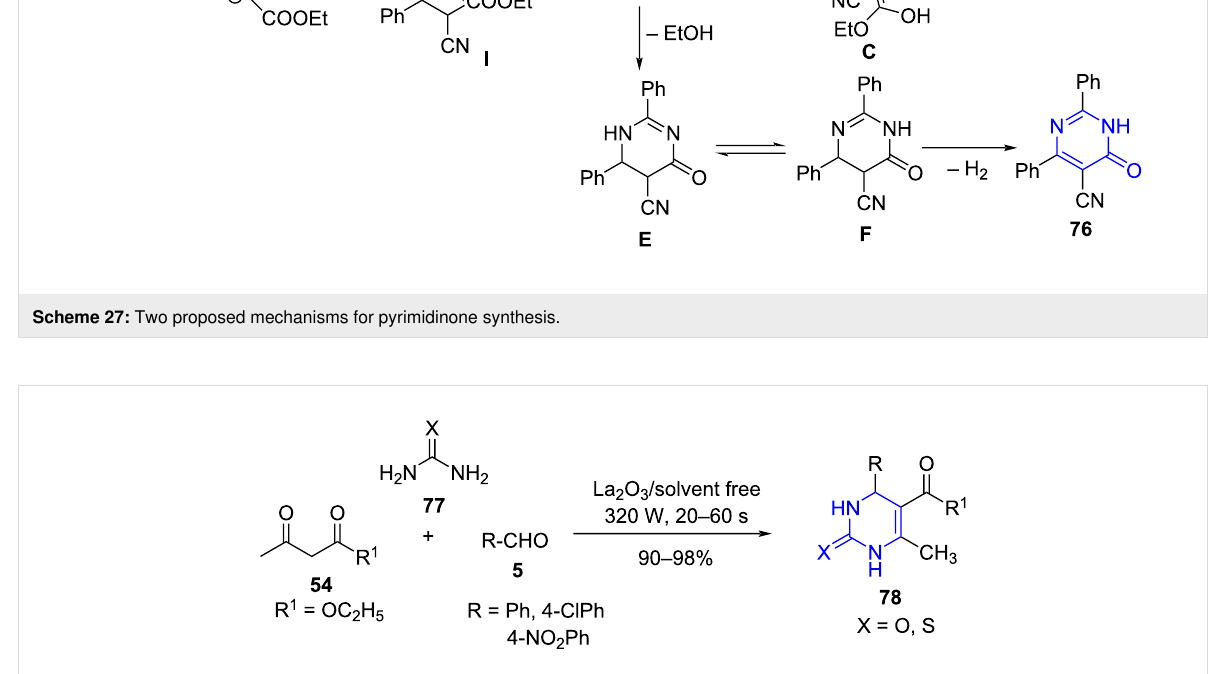
Scheme 28: MWA multicomponent synthesis of